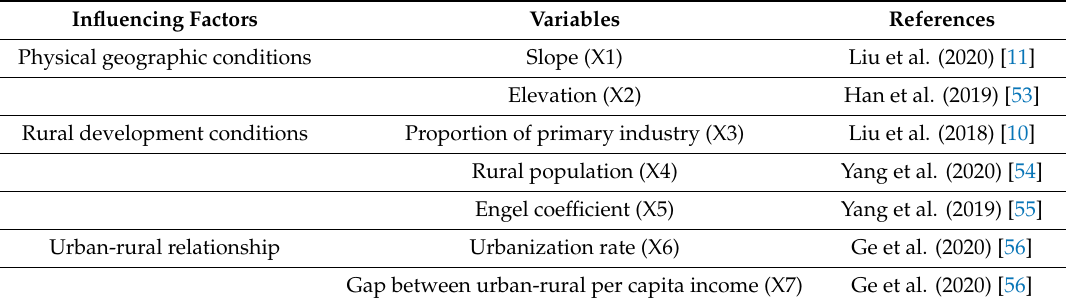
Table 2. The variables representing influencing factors on rural land resource allocation e ffi ciency